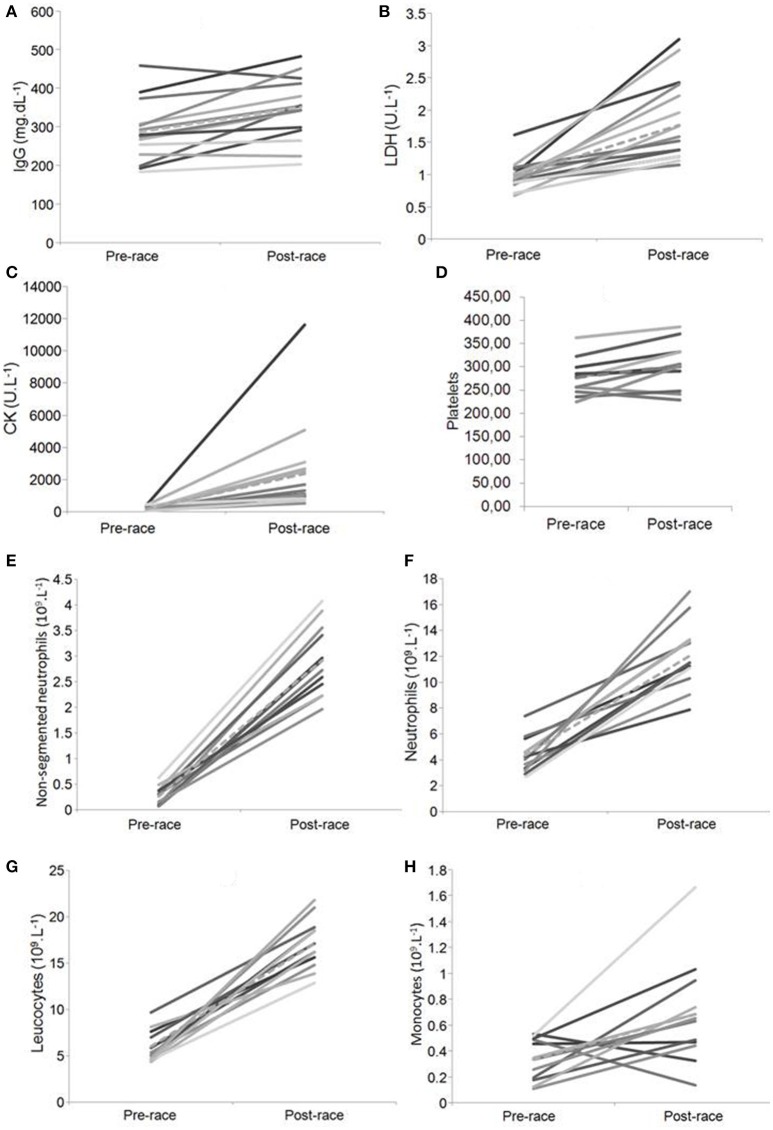
Statistically significant changes in pre- and post-race levels of IgG, LDH, CK, platelets, number of non-segmented (immature) neutrophil granulocytes, neutrophil granulocytes, leukocytes *Note. Dashed line–Mean value; (A) IgG, (B) LDH, (C) CK, (D) Platelets, (E) Non-segmented (immature) neutrophils, (F) Neutrophils, (G) Leukocytes, (H) Monocytes.